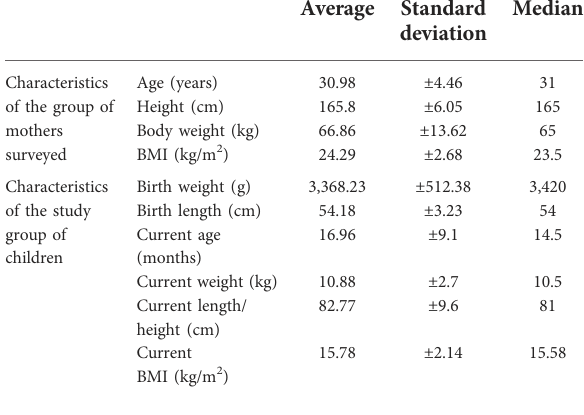
TABLE 1 Characteristics of the study group of mothers and their children ( N